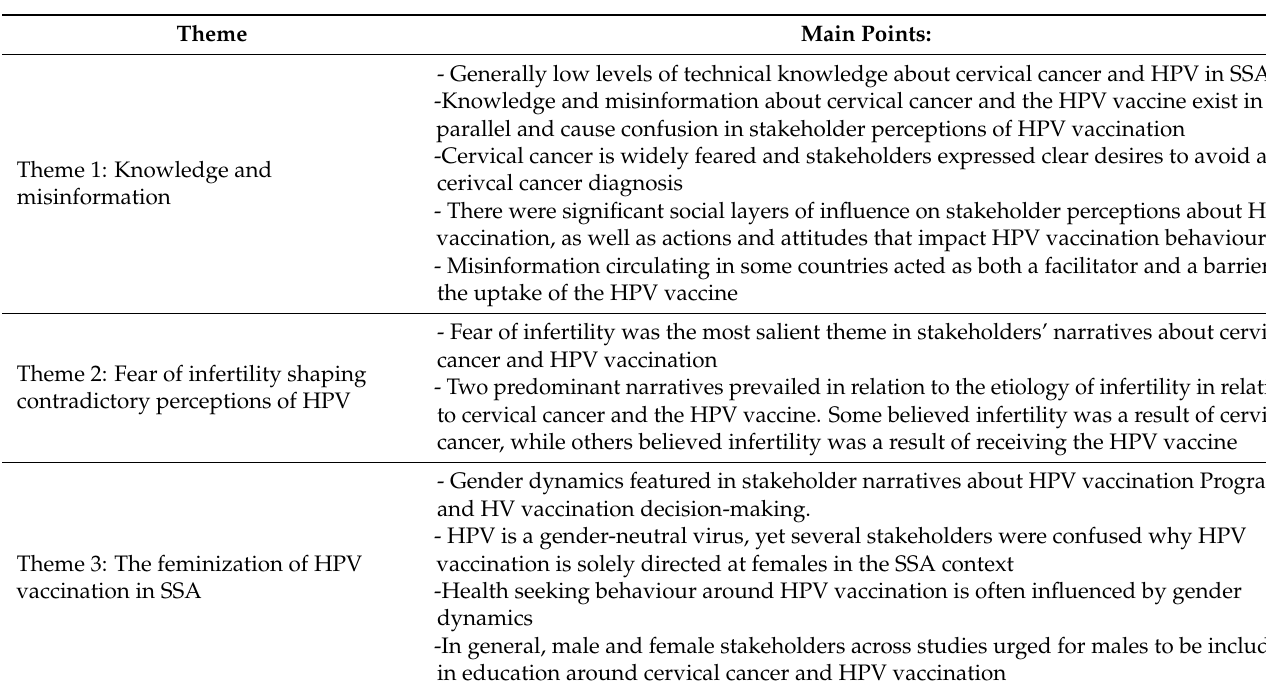
Table 1. Summary of themes and